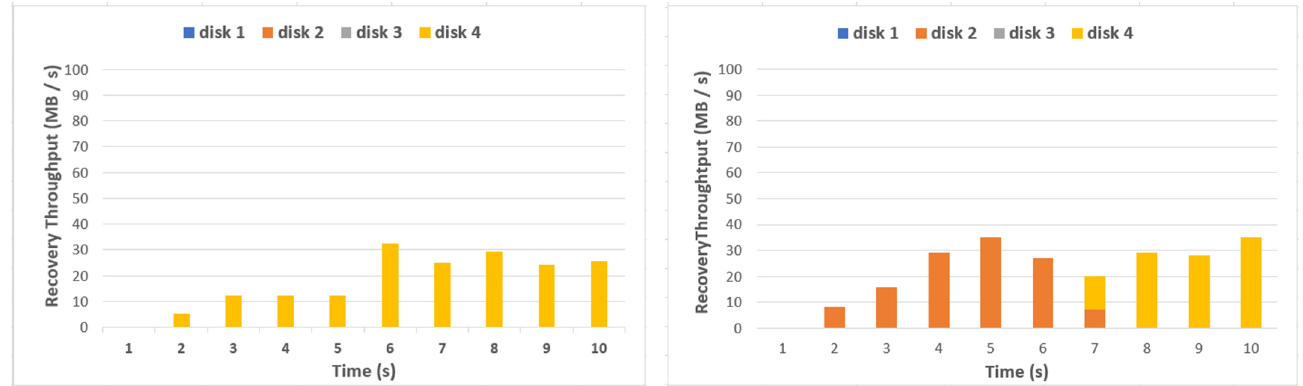
Figure 5. Disk usage in DataNode 1 during single-thread fault recovery.